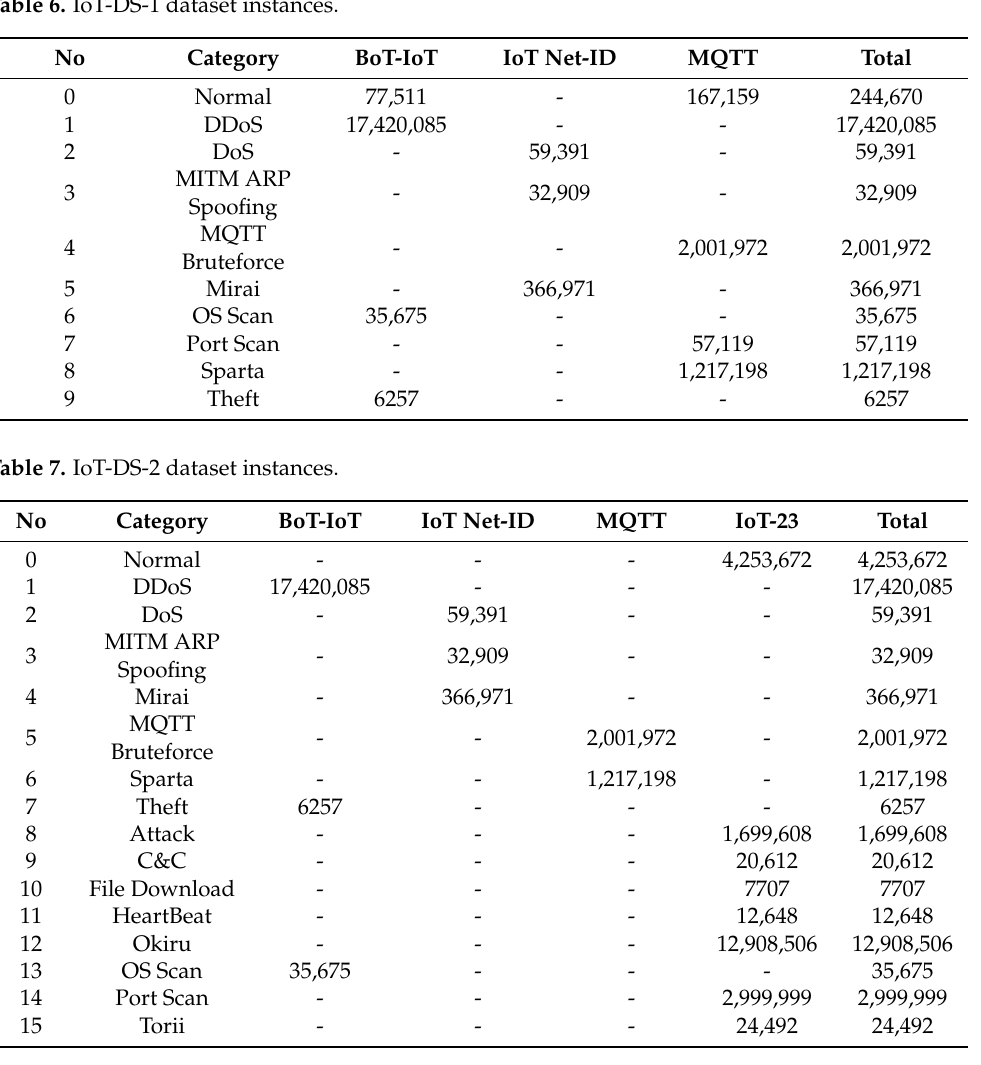
Table 6. IoT-DS-1 dataset instances.